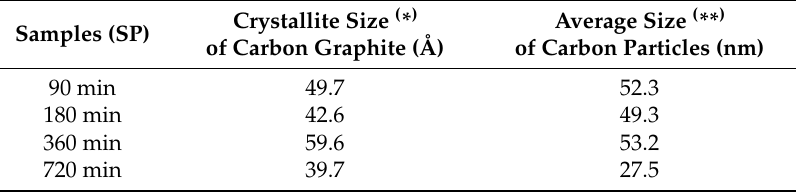
Table 1. Estimation of carbon crystallite size using XRD and TEM techniques.